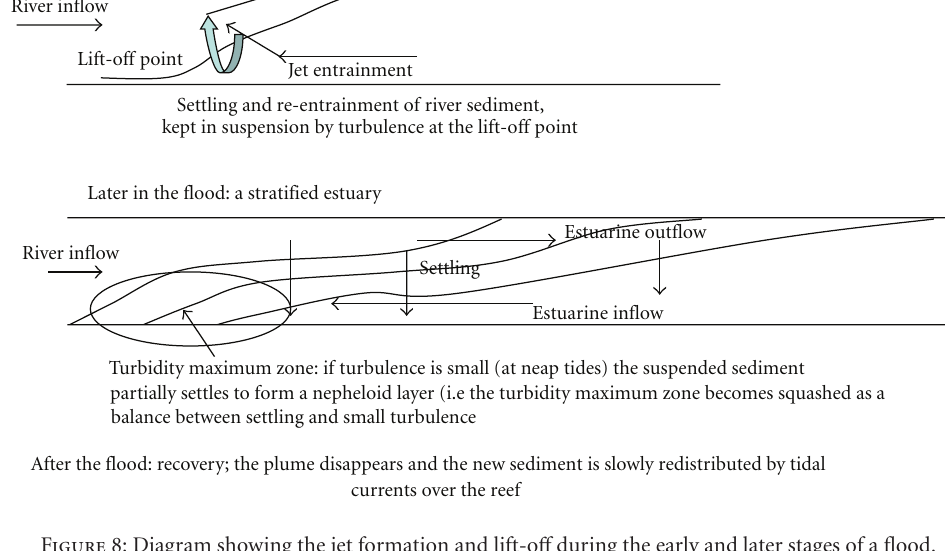
Figure 8: Diagram showing the jet formation and lift-o ff during the early and later stages of a